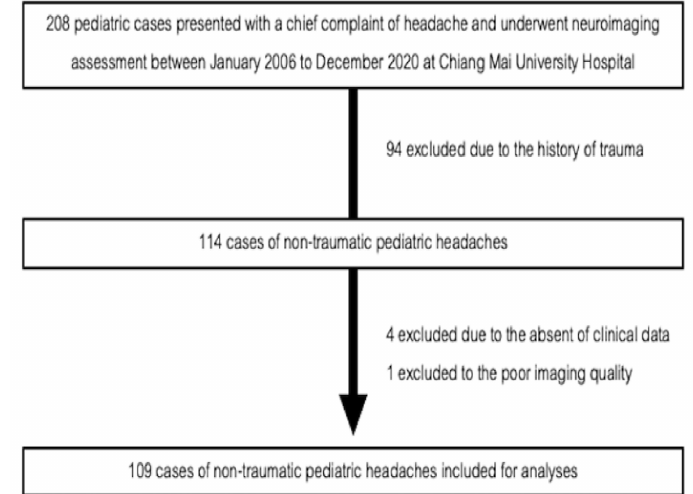
Figure 1. Flowchart of patient